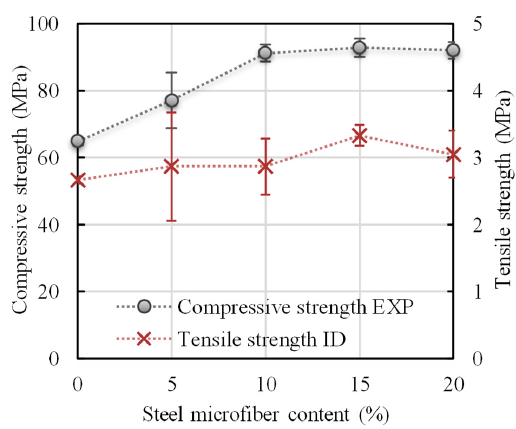
Figure 6. Compressive and tensile strength of AAS mortar with different amounts of steel microfibers. The tensile strength value was obtained by identification from measured F–d